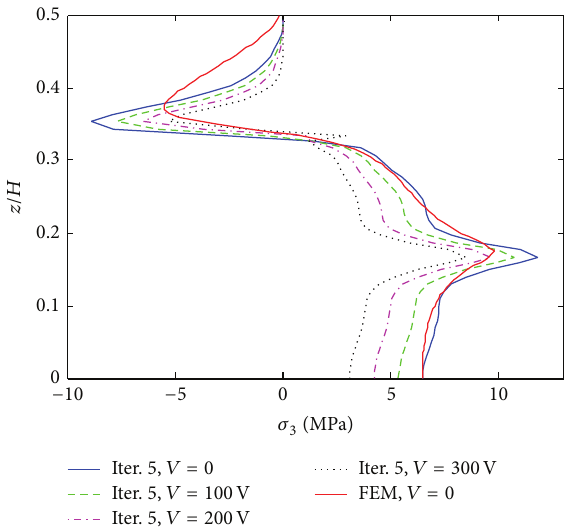
Figure 9: 𝜎 3 distribution of [PZT/45 4 / − 45 4 ]s laminate at the free edge, under − 0.1% uniaxial